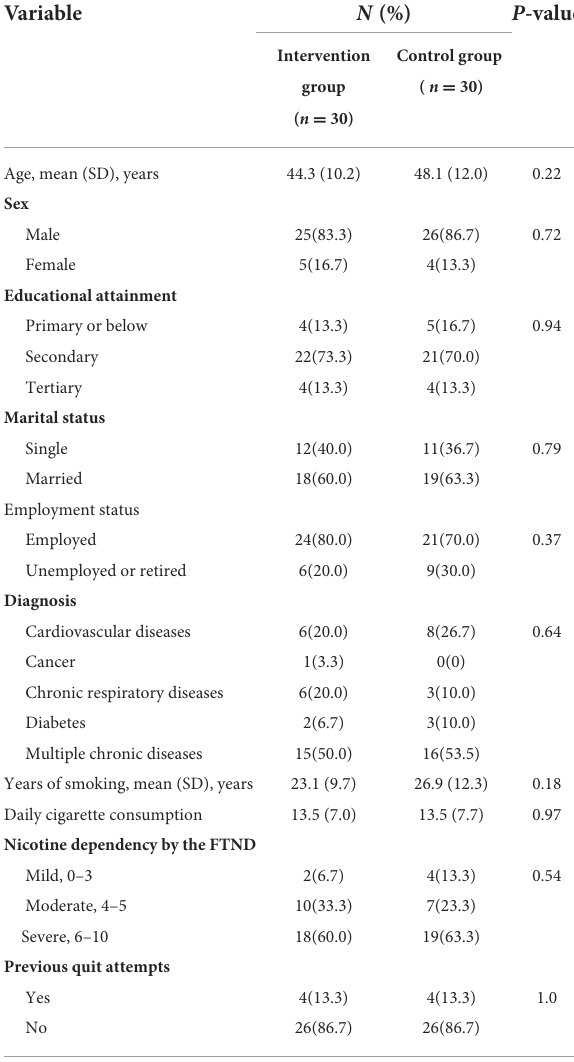
TABLE 2 Participants’ demographic and smoking